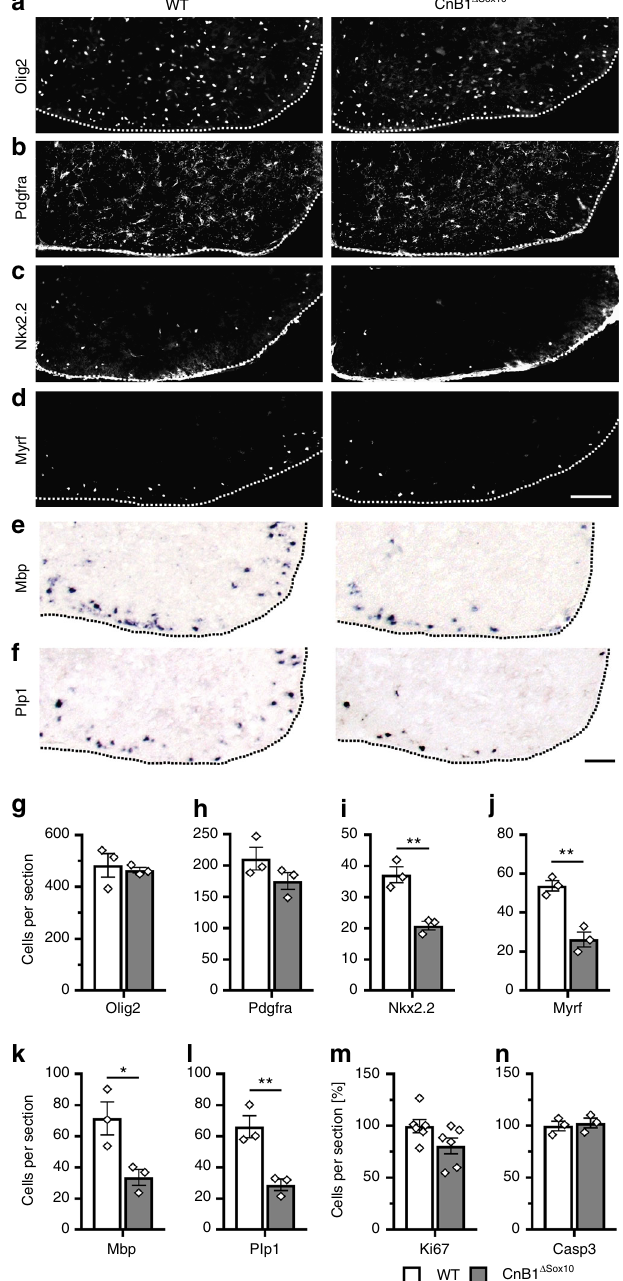
Fig. 2 Nfat/calcineurin signaling is required for oligodendroglial differentiation in vivo. a – f Analysis of oligodendroglial marker expression in 18.5 dpc-old embryos of wildtype (WT) and CnB1 Δ Sox10 mice by immunohistochemistry and in situ hybridization. Antibodies were directed against Olig2 ( a ), Pdgfra ( b ), Nkx2.2 ( c ), and Myrf ( d ). Riboprobes and similar stainings for Ki67 ( m ) and cleaved caspase 3 ( n ) quanti fi cations were performed on three or six embryos for each genotype ( n = 3 for g – l and n , n = 6 for m ) counting three separate sections. Presentations are as absolute ( g – l ) or relative ( m , n ) numbers (values: Olig2: 483 ± 46 for WT and 465 ± 11 for CnB1 Δ Sox10 ; Pdgfra: 211 ± 18 for WT and 175 ± 13